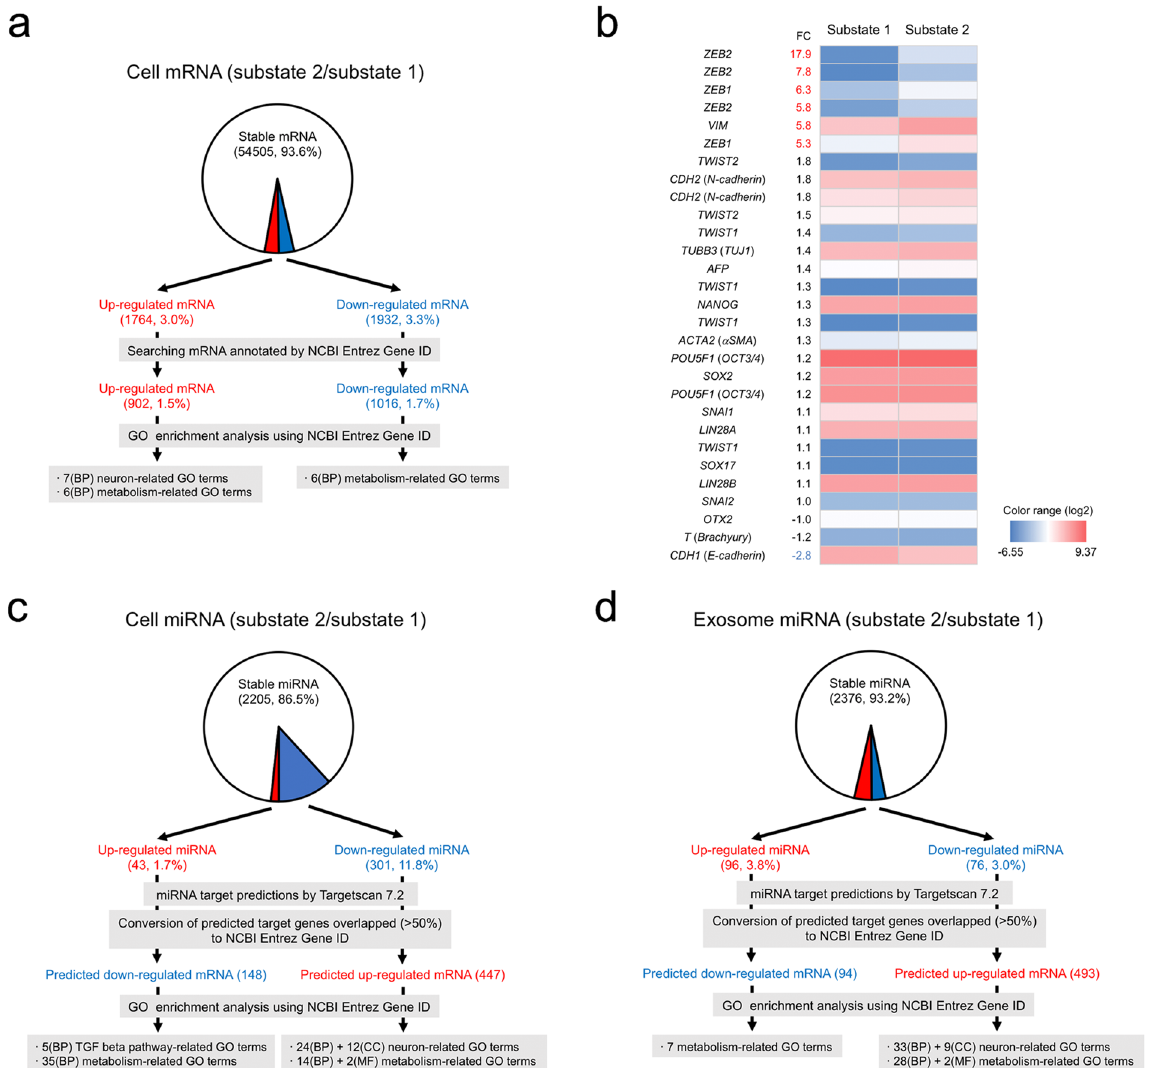
Figure 5. mRNA and miRNA expression analysis for cells in substate 1 and substate 2. ( a ) mRNA microarray analysis. Analysis of significance was performed using Z-score of substate 2 versus substate 1 (see Supplementary Fig. S1). The symbols of the obtained mRNAs were converted to NCBI Entrez Gene IDs by BioMart based on GRCh38.p12. GO enrichment analysis was performed using the IDs (false-discovery rate [FDR] ≤ 0.05, fold enrichment ≥ 1.5; see Supplementary Tables S2–S3). ( b ) Heat map showing pluripotency, epithelial-to-mesenchymal transition, and trilineage markers. The map was constructed using the mRNA microarray data of pluripotency markers ( CDH1 [E-cadherin], CDH2 [N-cadherin], LIN28A , LIN28B , NANOG , POU5F1 [ OCT3/4 ], and SOX2 ), epithelial-to-mesenchymal transition markers ( SNAI1 , SNAI2 , TWIST1 , TWIST2 , ZEB1 , ZEB2 , and VIM ), and trilineage markers ( ACTA2 [ aSMA ], AFP , OTX2 , SOX17 , T [brachyury], and TUBB3 [ TUJ1 ]) (see Supplementary Table S4). The red and blue coloured fold change (FC) numbers indicate significantly higher and lower expression in substate 2 than in substate 1, respectively. ( c and d ) miRNA microarray analysis of the cells ( c ) and exosomes ( d ). The miRNAs that showed a 2-fold difference in expression between substate 1 and substate 2 cells were subjected to analysis of significance using paired t-test with multiple testing correction (q < 0.05; Supplementary Tables S5–8). The miRNA target prediction was performed by Targetscan 7.2. The predicted up- and downregulated mRNAs were derived from the down- and upregulated miRNAs, respectively (see Supplementary Tables S9–S12). The symbols were converted to NCBI Entrez Gene IDs using BioMart based on GRCh38.p12 (see Supplementary Tables S9–S12). GO enrichment analysis was performed using the IDs of genes targeted by more than 50% miRNAs (false-discovery rate [FDR] ≤ 0.05, fold enrichment ≥ 1.5; see Supplementary Tables